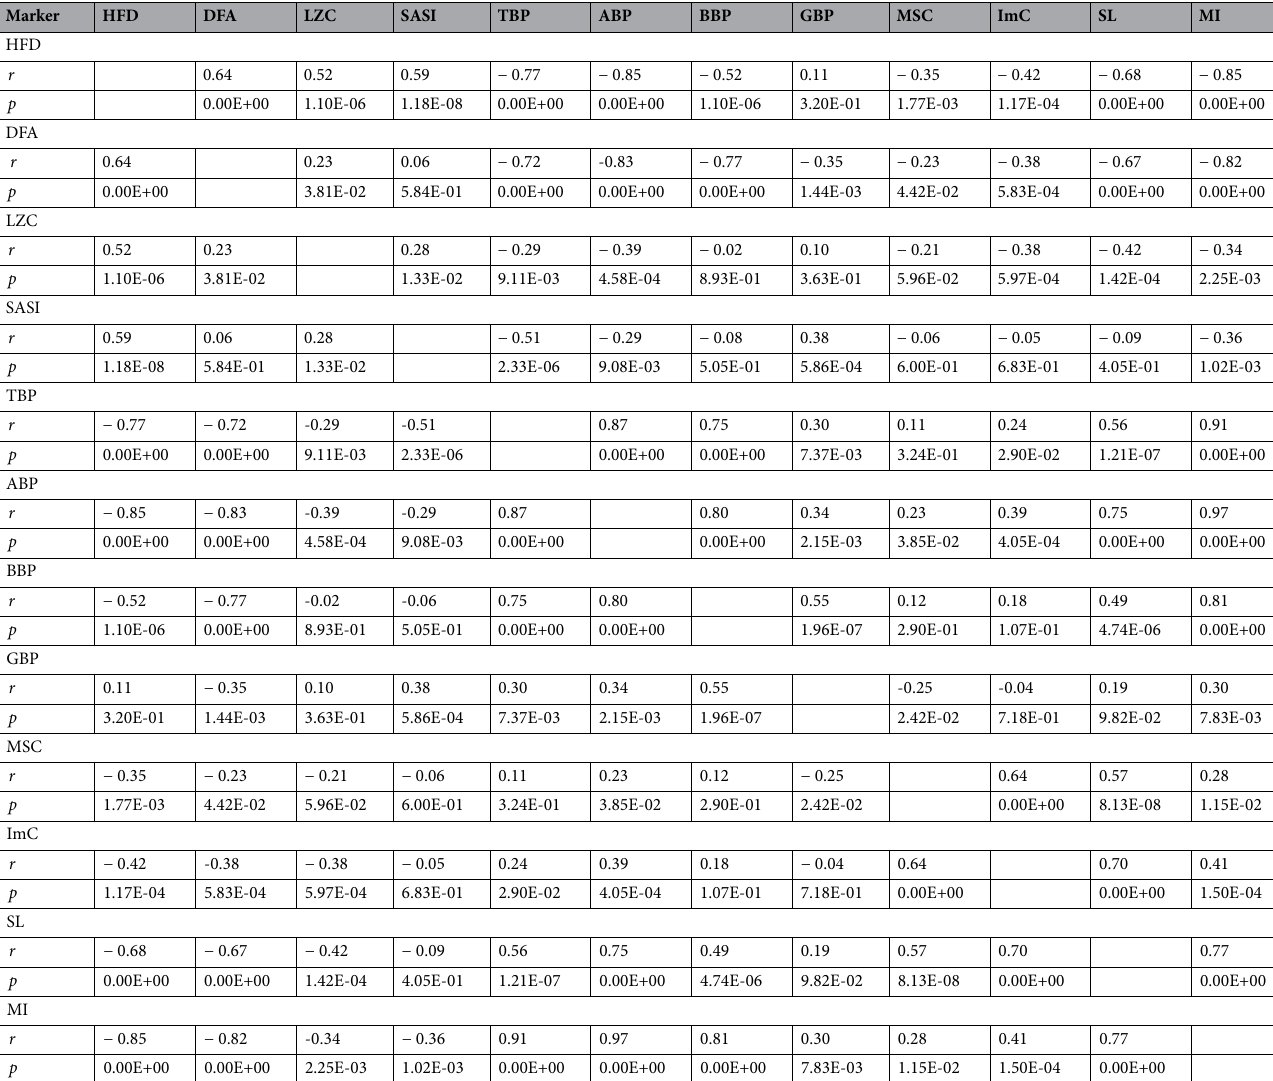
Table 1. The calculated Spearman correlation coefficients r between the pairs ( n = 80) of different markers and corresponding p- values estimated by t-test. The p < 0.00076 (|r|> 0.37) indicates statistical